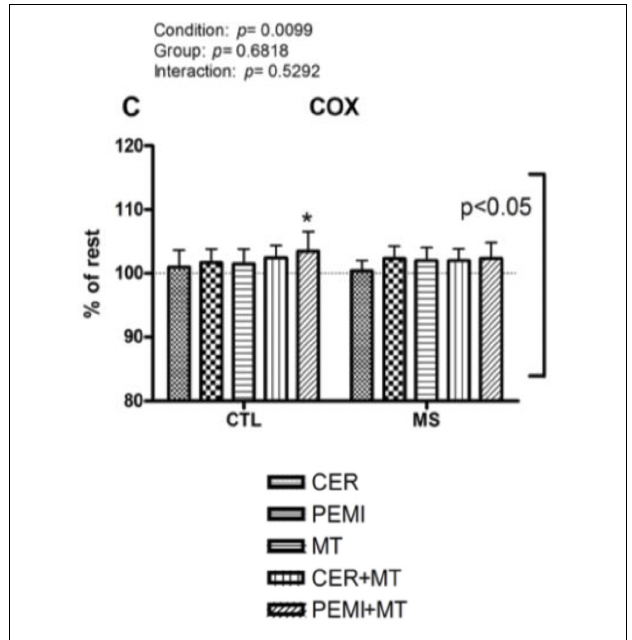
FIGURE 2 | Cerebral oxygenation data during control exercise recovery (CER), post-exercise muscle ischemia (PEMI), mental task (MT), control exercise recovery + mental task (CER + MT), and post-exercise muscle ischemia + mental task (PEMI + MT) tests in the metabolic syndrome (MS, n = 13) and the control (CTL, n = 14) groups. The dotted line indicates rest level. Values are mean ± SD. A horizontal bracket indicates the overall main effect of groups; a vertical bracket indicates the overall main effect of condition. ∗ p < 0.05 vs. CER test of the same